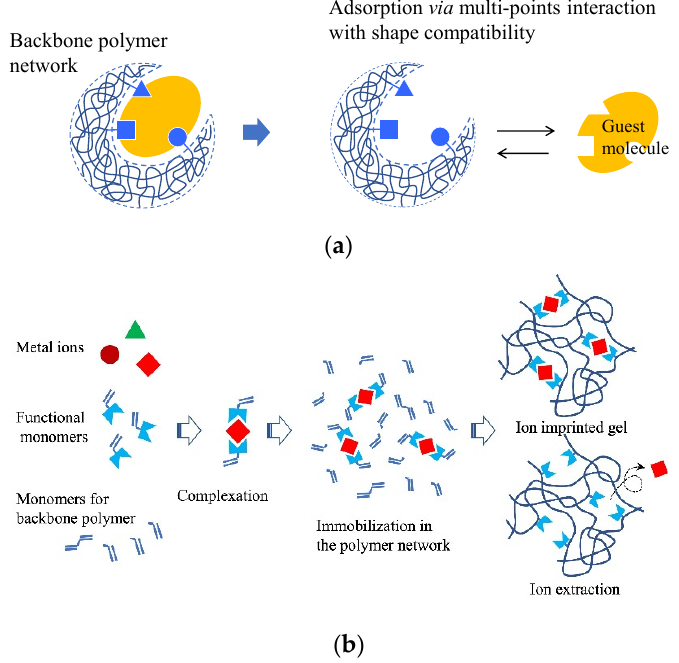
Figure 5. Schematic diagram of ( a ) molecular imprint and ( b ) ion imprint gels.